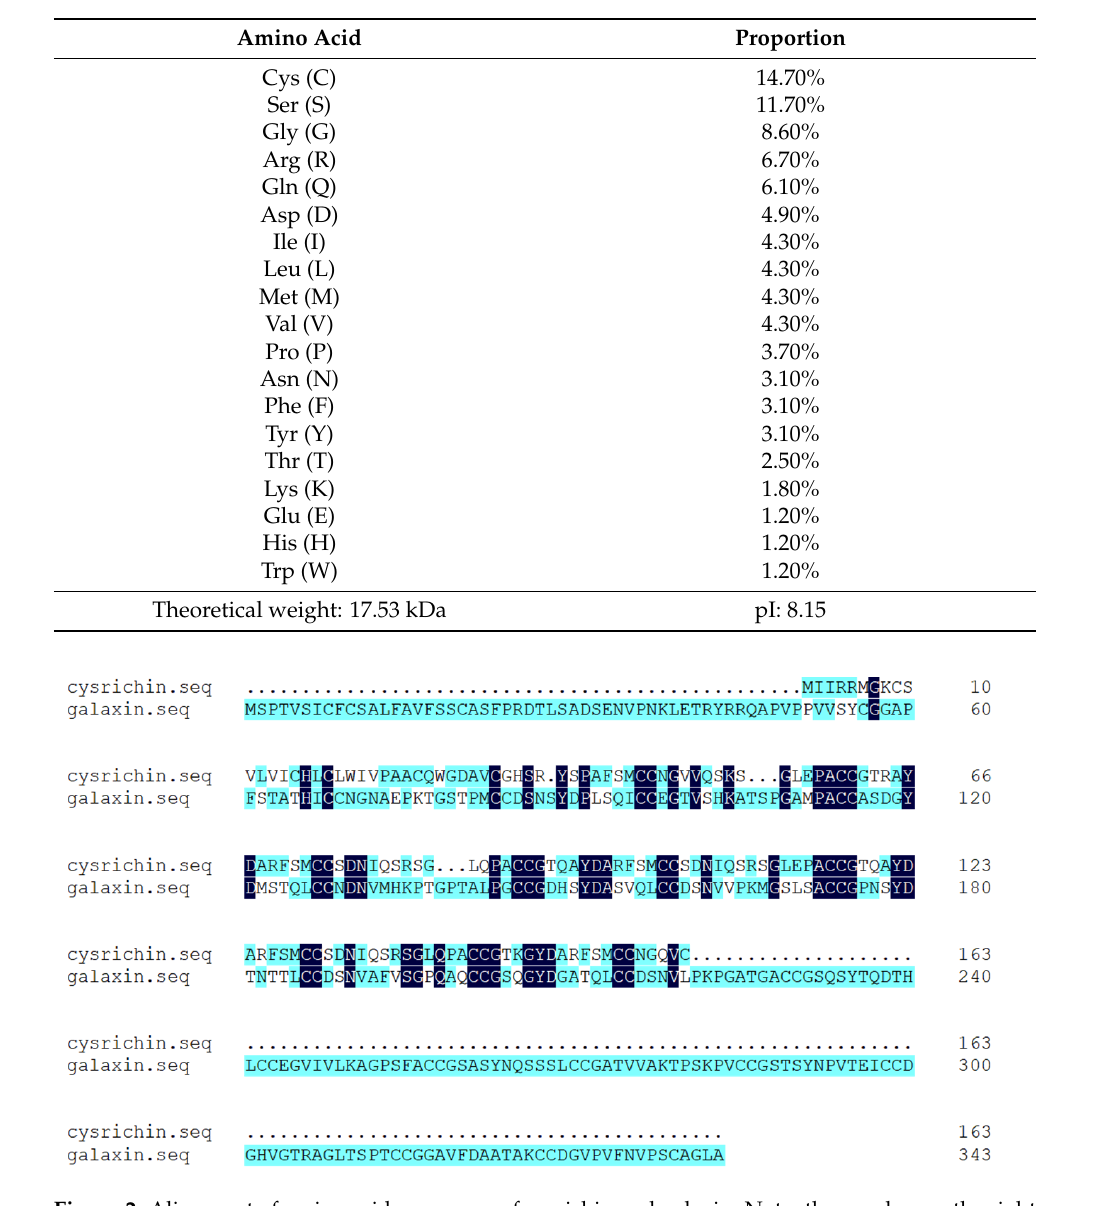
Figure 3. The tandem repeat structure in galaxin and cysrichin. Note: The information about galaxin was obtained from the study of Fukuda et al. [14] , GenBank Accession No. AB086183. The galaxin protein was isolated from coral Galaxea fascicularis . Numbers on the left indicate the position in the predicted protein, and “ − ” represents an arbitrary amino acid. The consensus sequence for the repeats from each protein is shown beneath the alignments.